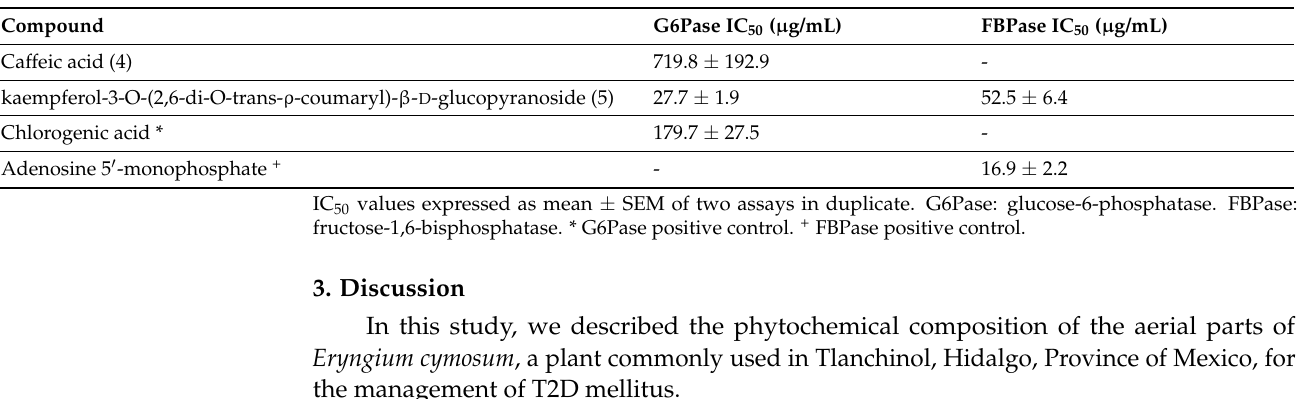
Table 2. Inhibitory activity of identified compounds on enzymes involved in glucose-producing